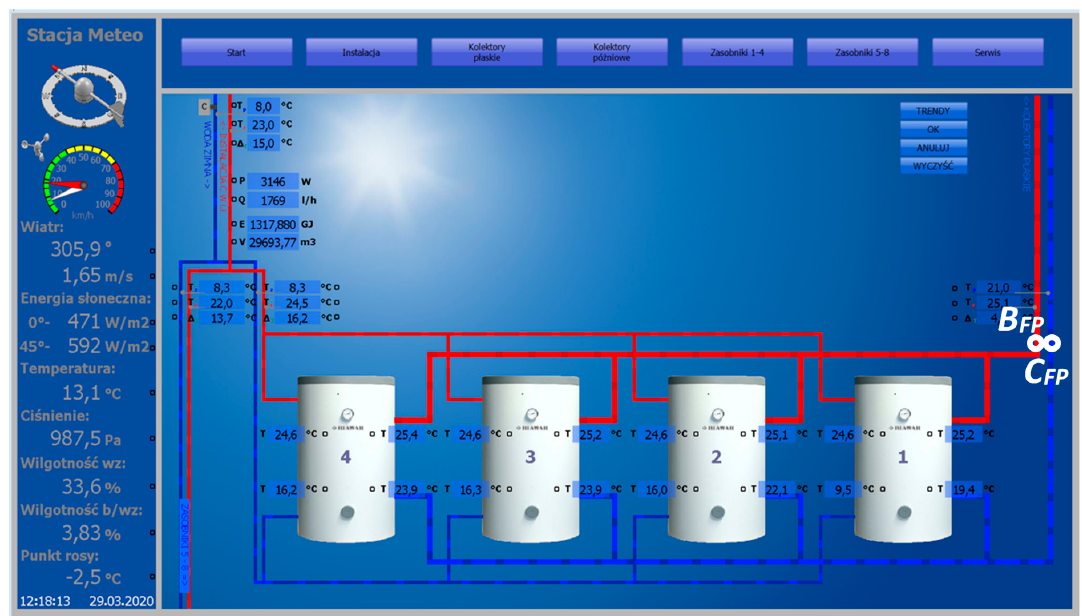
Figure 8. Screenshot of the monitoring system—tanks connected with flat plate solar collectors.